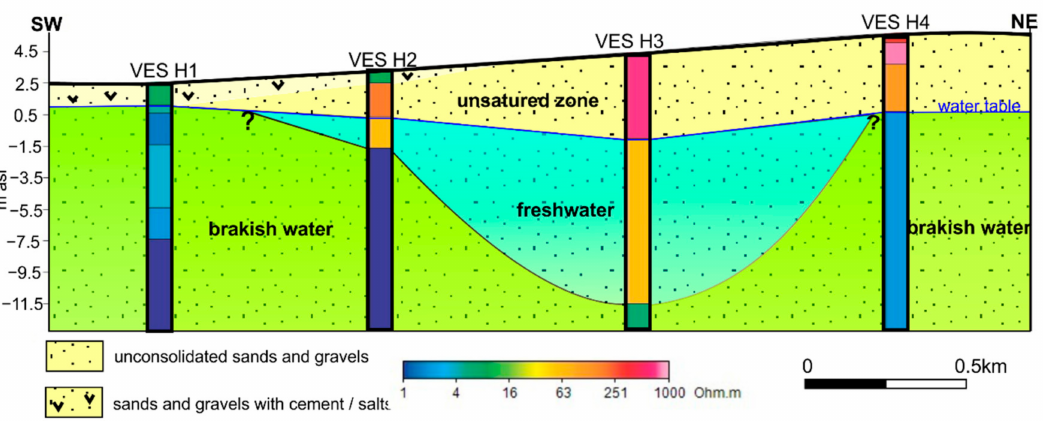
Figure 4. Vertical electric soundings of Holocene beach